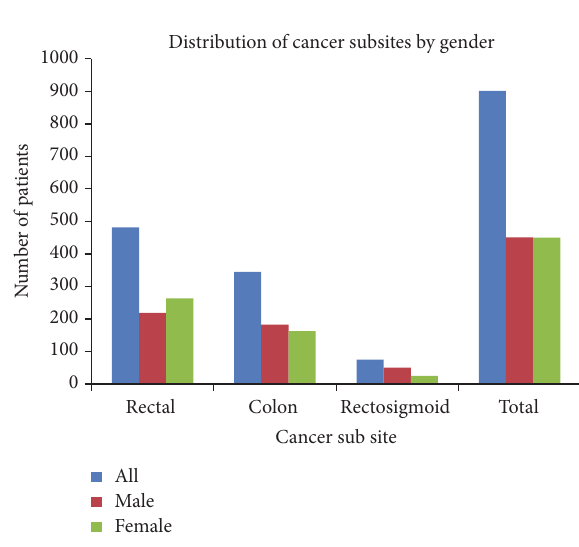
Figure 6: CRC cases distribution by subsite and